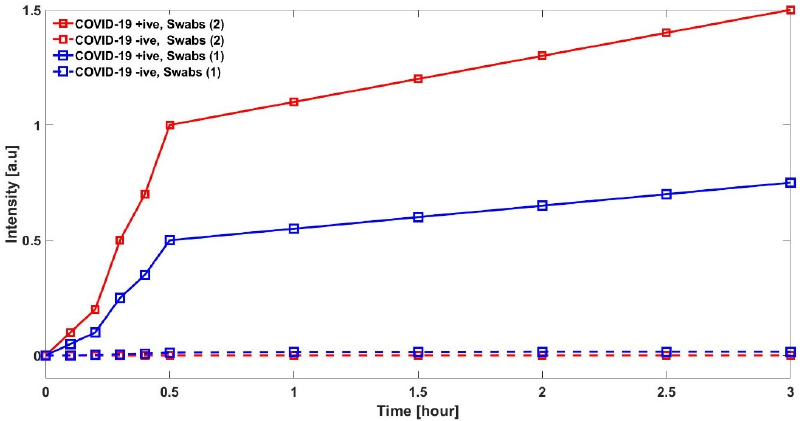
Figure 7. Comparison of two POFs in terms of intensity with diameter 200 µm, compared with specimen taken from oropharyngeal or/and nasopharyngeal.